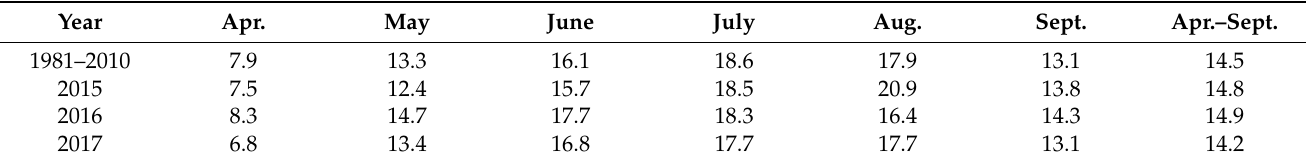
Table 1. Average monthly air temperature in Mochełek in the years of research against the long-term averages ( ◦ C).